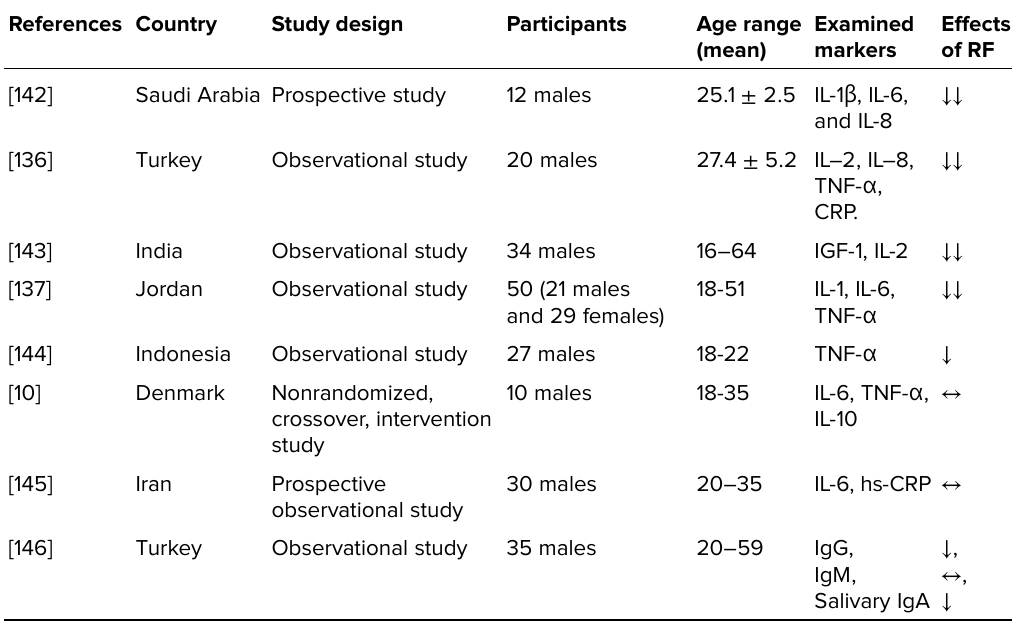
TABLE 1: A summary of studies that have investigated the effects of RF on immune biomarkers. References